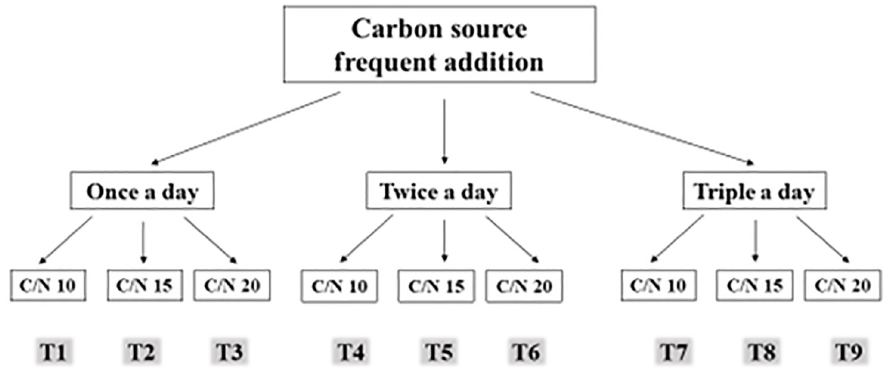
Fig 9. Experimental design. A factorial design with nine treatments. The effect of carbon source (starch) frequent addition (once, twice, triple) at daily basis, and C/N ratio (10, 15, 20) interaction on shrimp Litopeaneus vanname gut microbiota